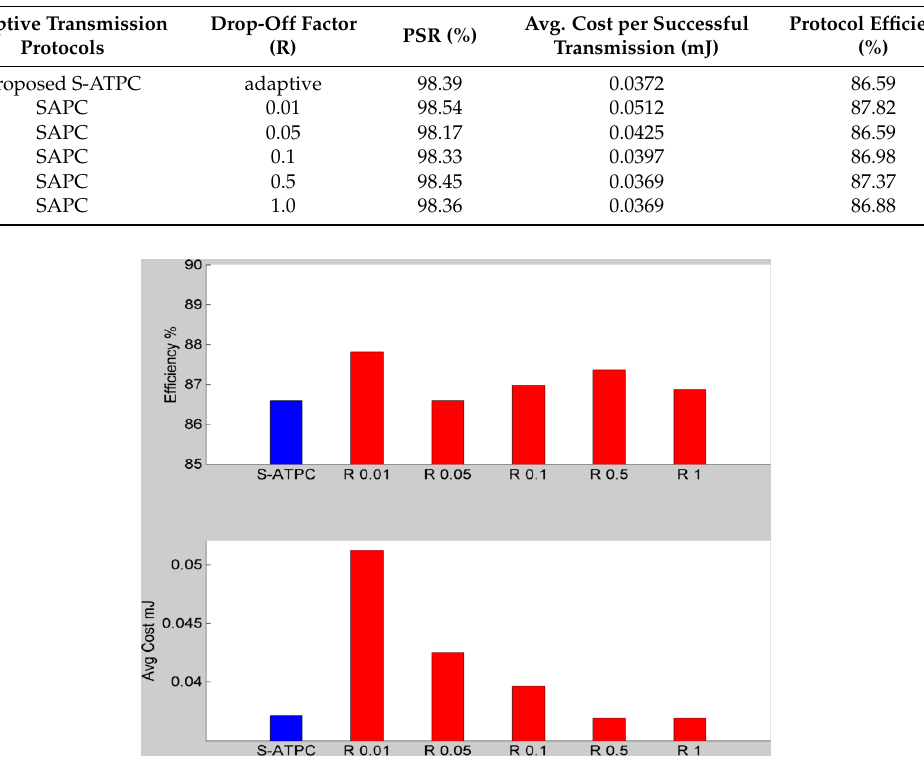
Figure 11. Experimental results: The protocol efficiencies and the average cost of success transmissions are compared when the PSR for all the cases are equal to 99%.